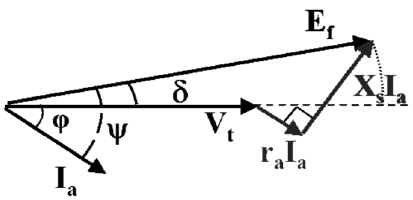
Figure 9. Generator’s voltage vector diagram in leading mode.